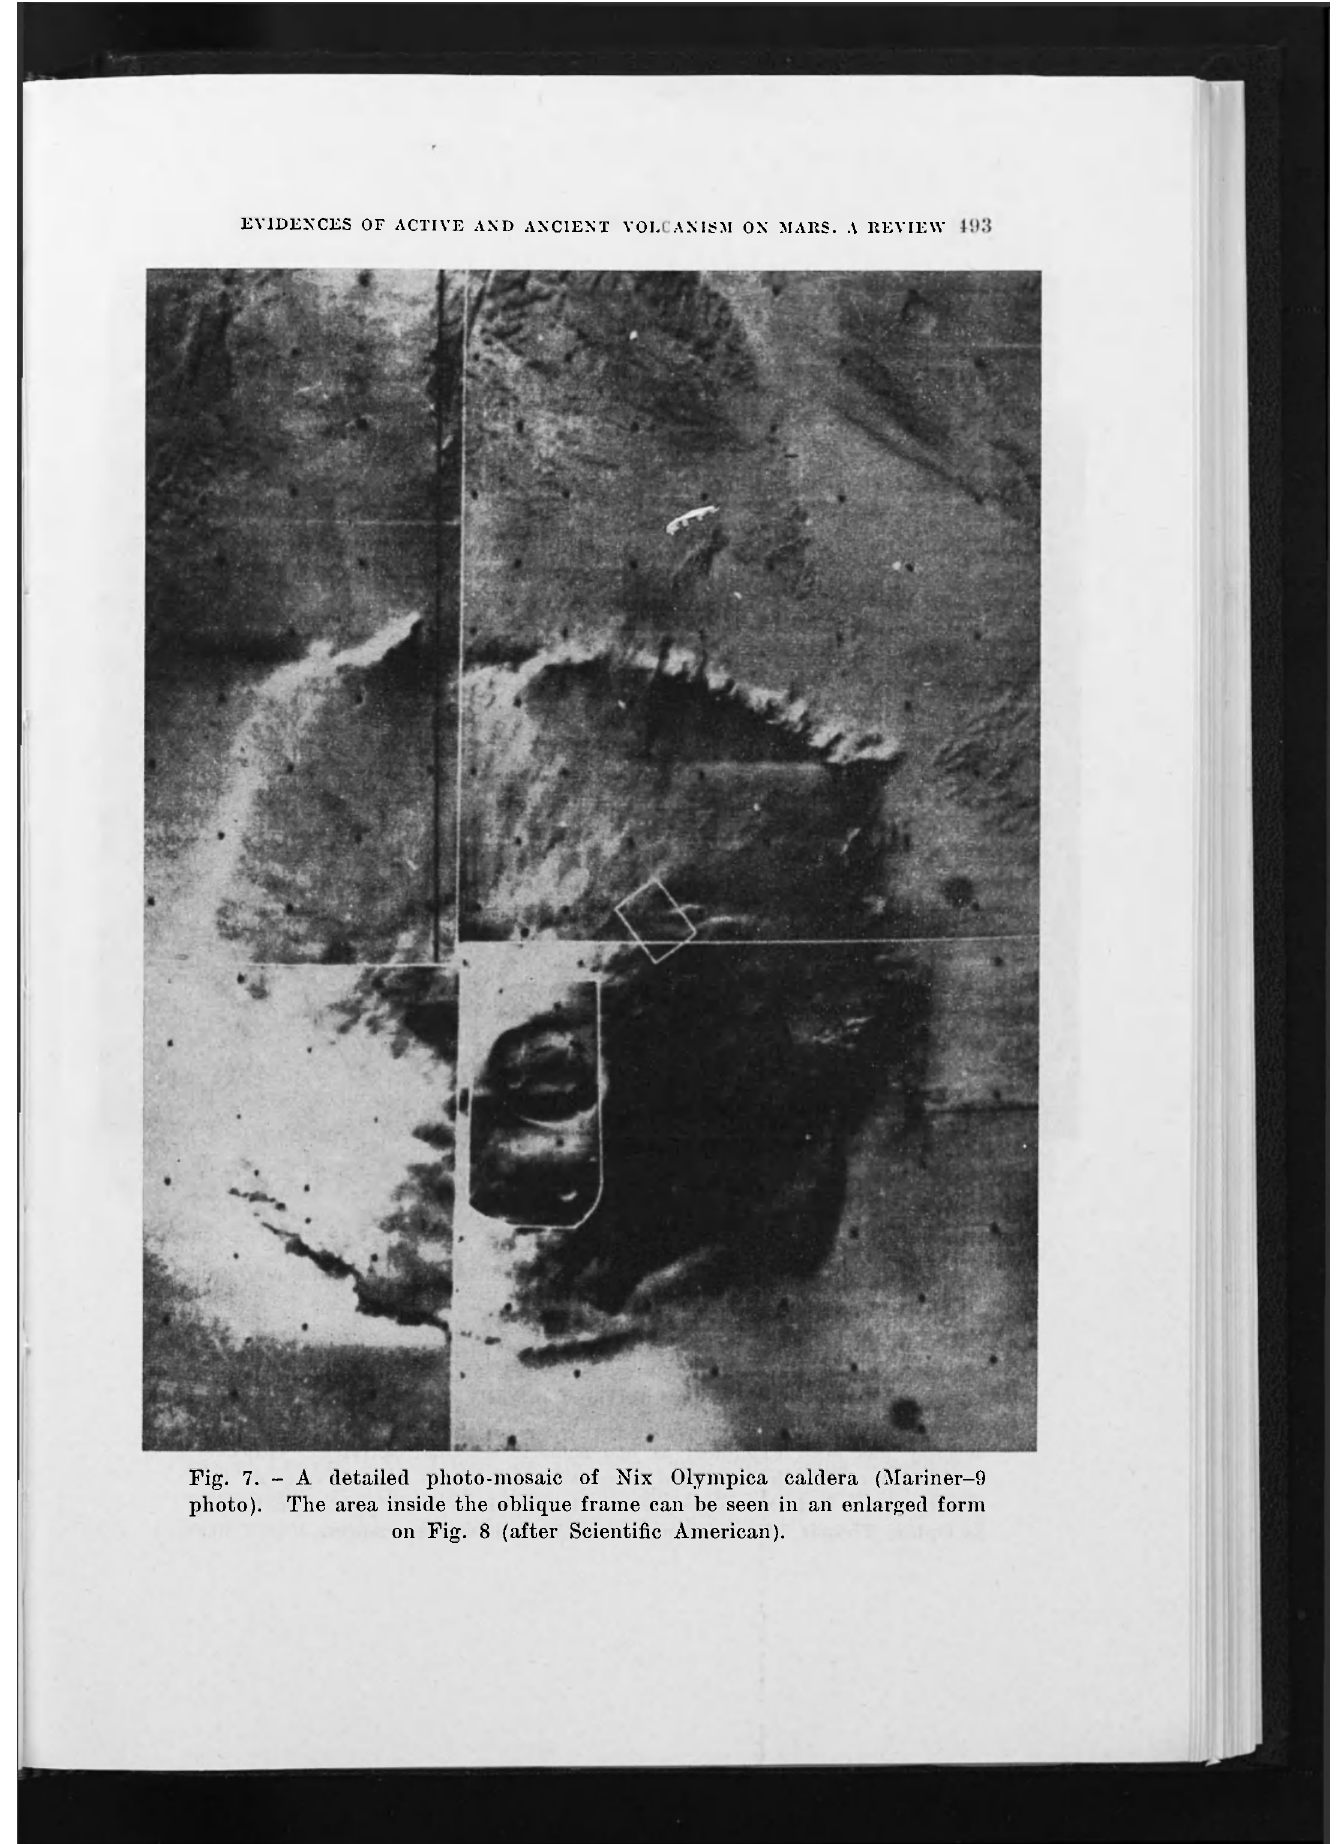
Fig. 7. - A detailed plioto-mosaic of Nix Olympica caldera (Mariner-9 photo). The area inside the oblique frame can be seen in an enlarged form on Fig. 8 (after Scientific